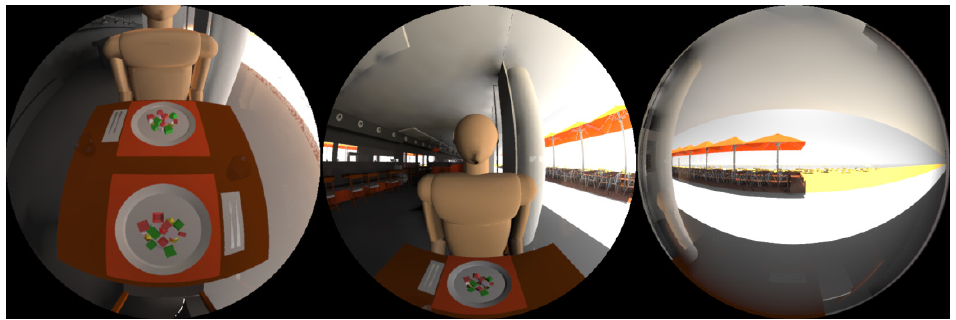
Figure 3. Simulated pictures of Sal Café restaurant with each workplane: table, a person in front and window.